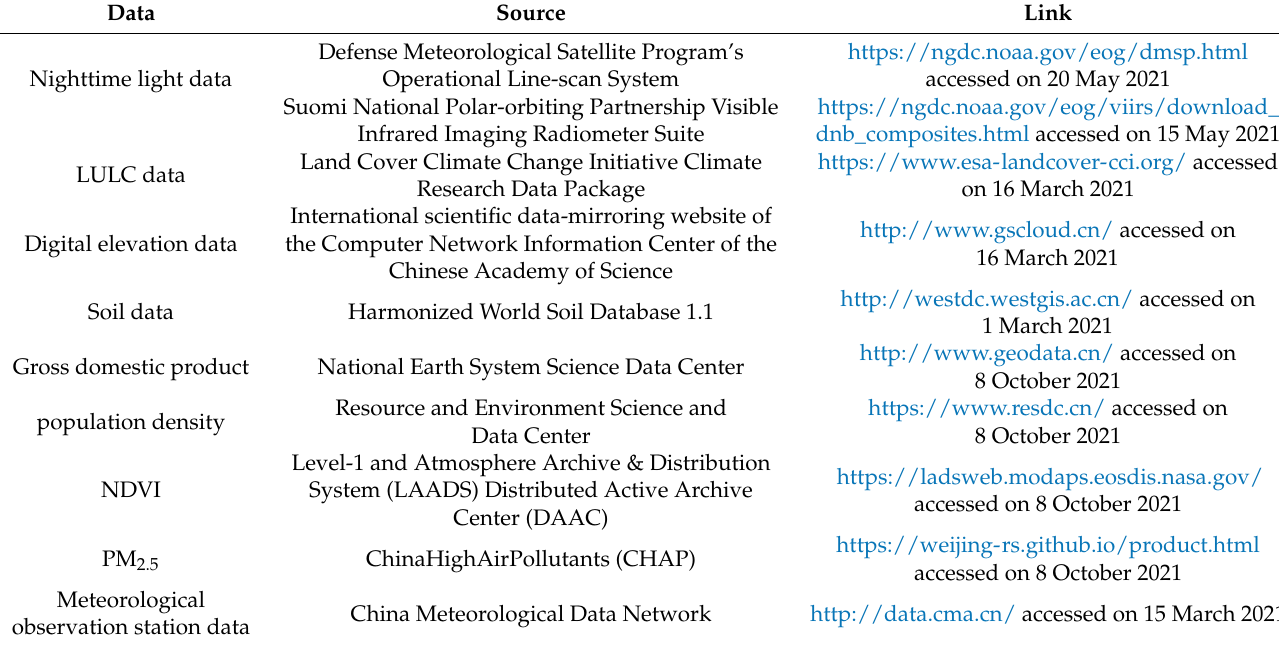
Table 1. Data category and